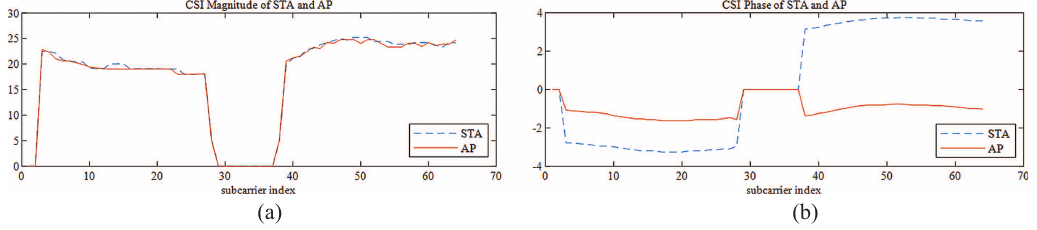
Figure 7. Raw CSI magnitude and phase maps: (a) Raw CSI magnitude map; (b) Raw CSI phase